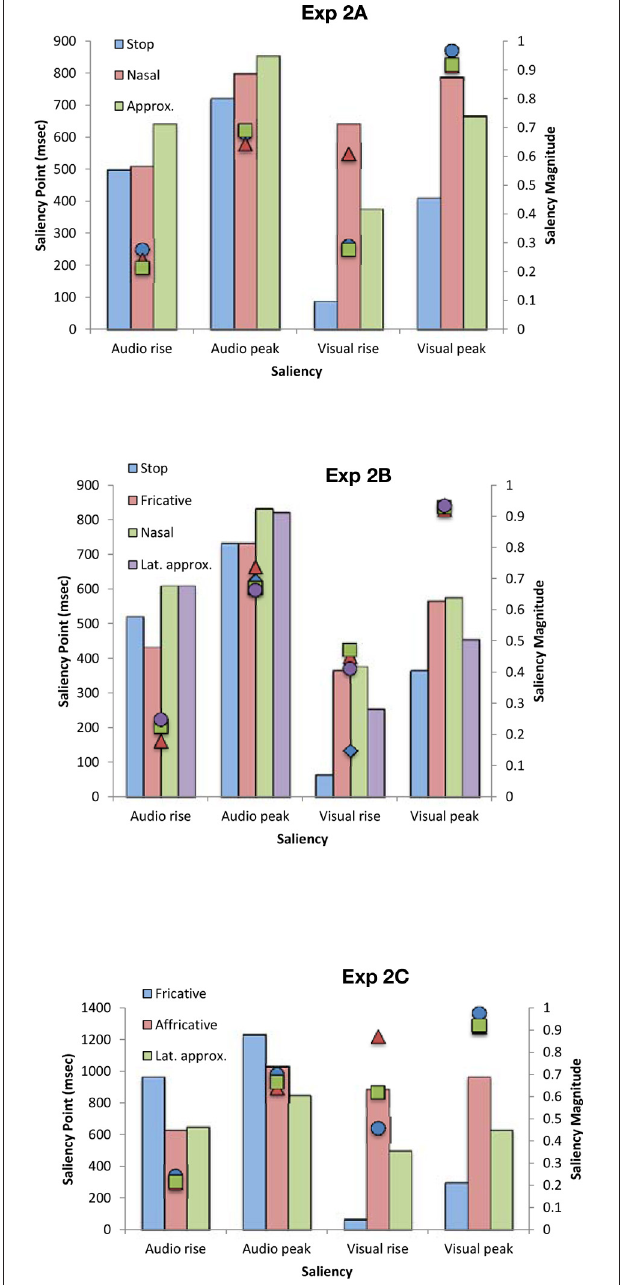
FIGURE 7 | Average saliency rise and peak (in ms) and saliency magnitude for each point for the audiovisual speech stimuli used in Experiments 2A–C as a function of the manner of articulation.